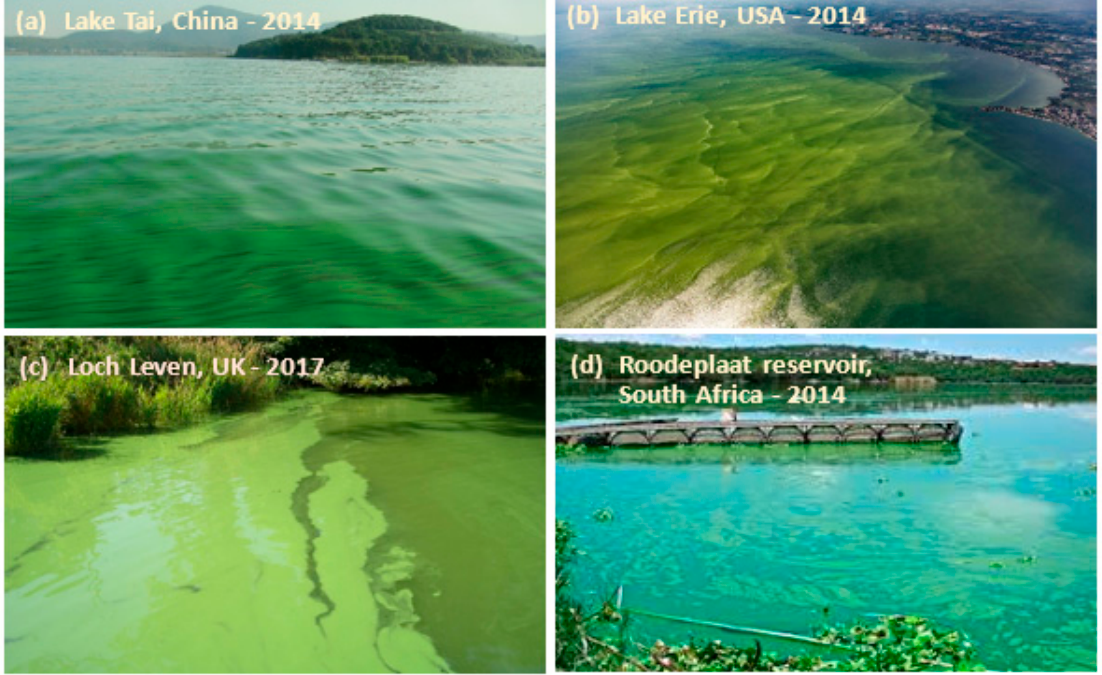
Figure 1. Cases of freshwater eutrophication in ( a ) China [2], ( b ) USA [3], ( c ) UK [4], and ( d ) South Africa [5]. Note: the photos were derived with modification from the original sources.